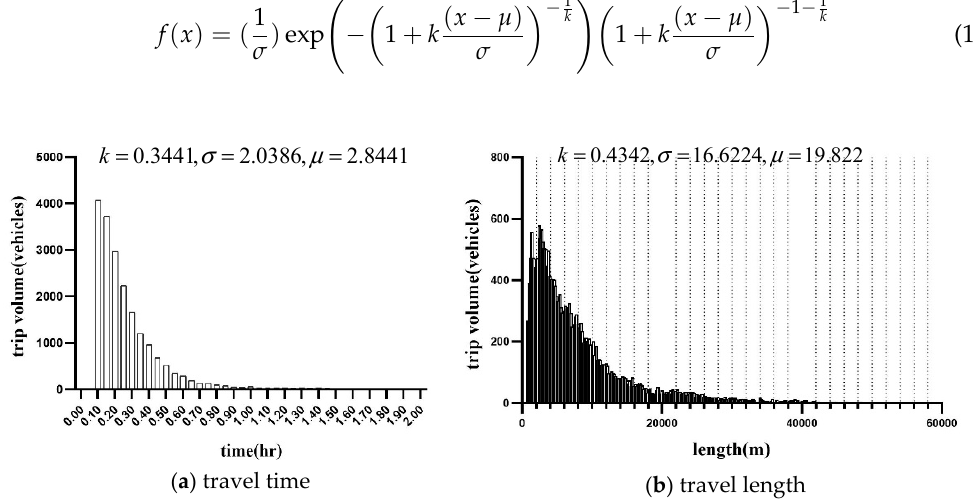
Figure 4. ( a , b ) Statistics on travel time and length of tourist trips.